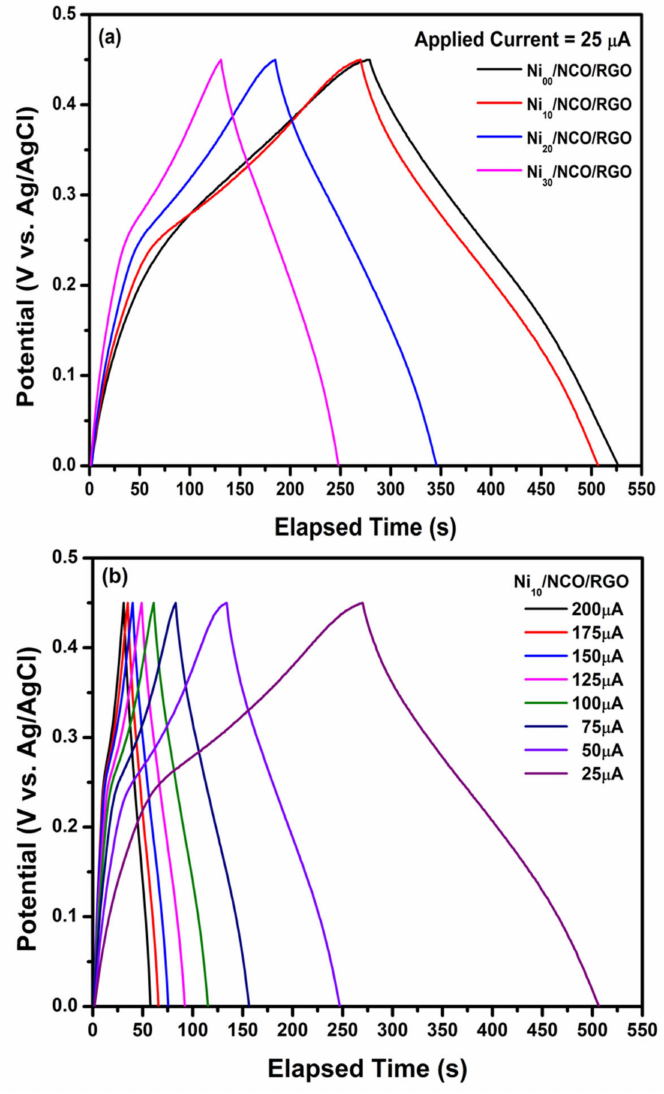
Figure 9. Galvanostatic charge/discharge (GCD) curves of ( a ) various Ni/NCO/RGO electrodes at applied currents of 25 µ A and ( b ) Ni 10 /NCO/RGO electrode at various applied